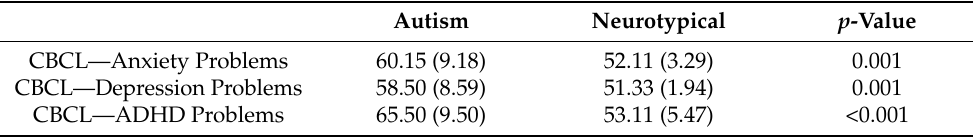
Table 3. Means of Child Functioning Variables by Diagnostic Group.